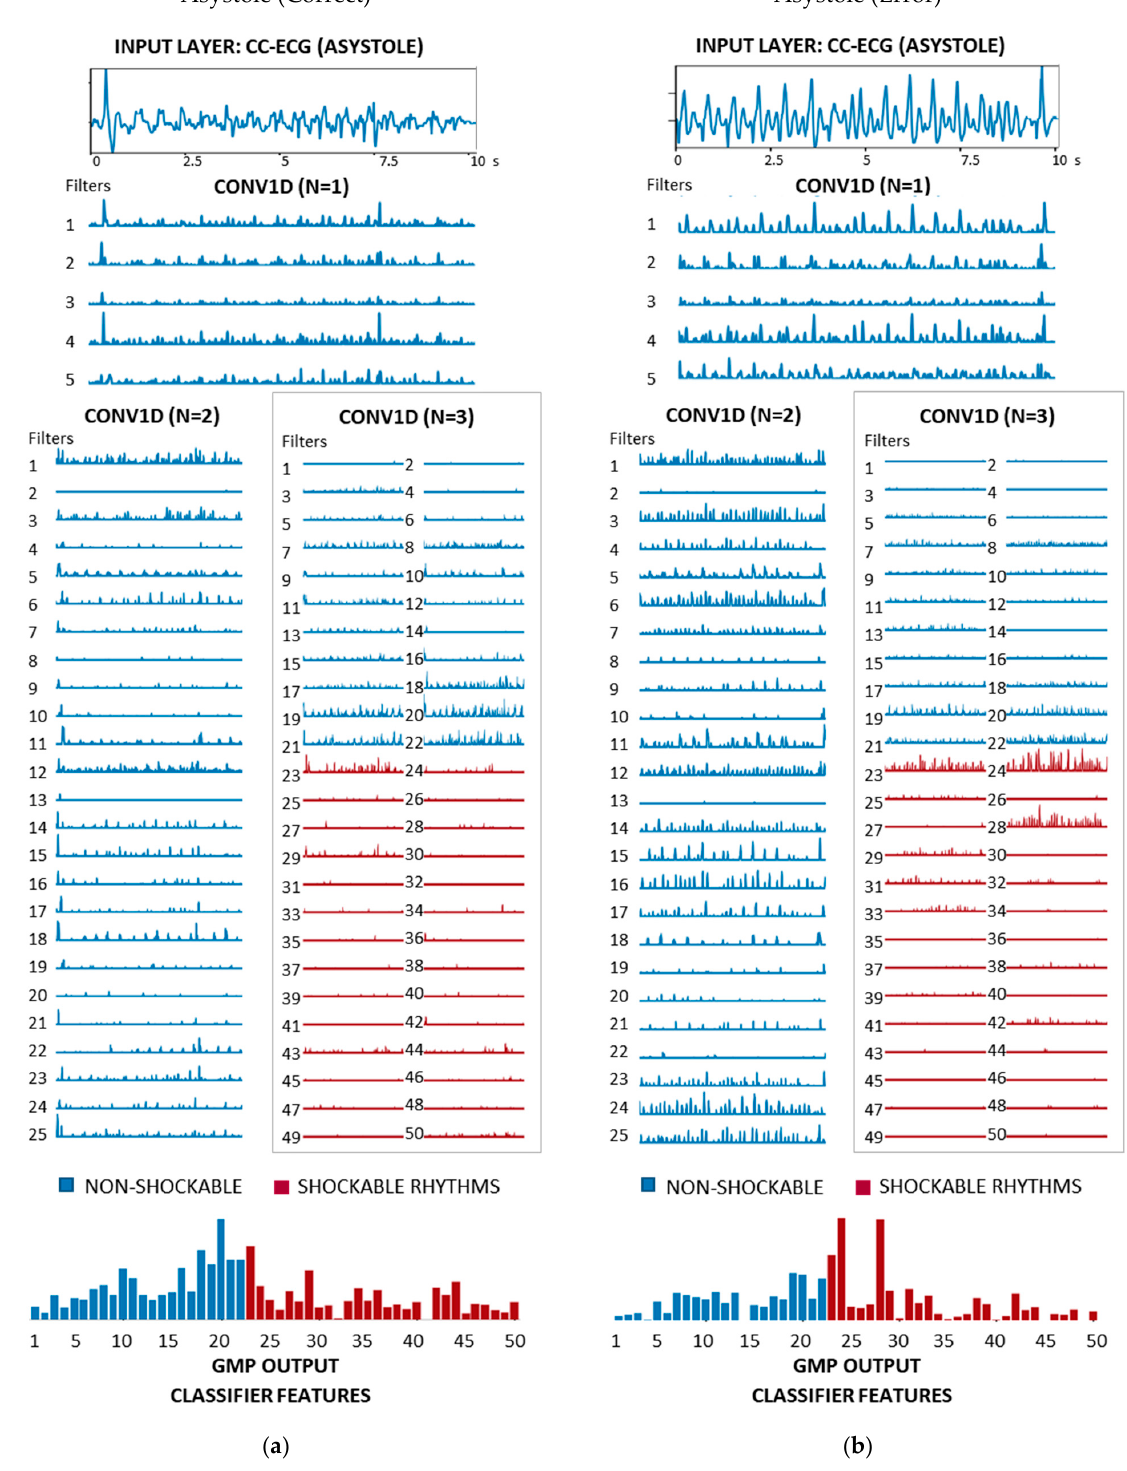
Figure 10. Features of CNN3-CC-ECG network computed for two examples of 10 s ECG-CC strips annotated as Asystole (Figure 1) with different shock advisory decisions: ( a ) Asystole (SNR = − 18 dB) correctly detected as NSh rhythm with output probability pSh = 0.006; ( b ) Asystole (SNR = − 24 dB) erroneously detected as Sh rhythm with output probability pSh = 0.81. The underlined 50 filters at the output of CONV1D (N = 3) are used for computation of 50 classifier features (bottom plot), grouped for Sh (red) and NSh (blue) rhythms in accordance to the sign of the classifier